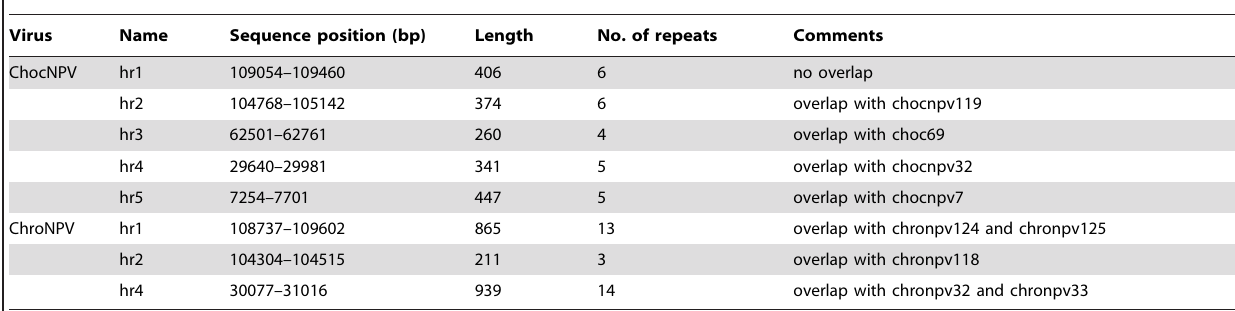
Table 2. Features of ChocNPV and ChroNPV hrs.